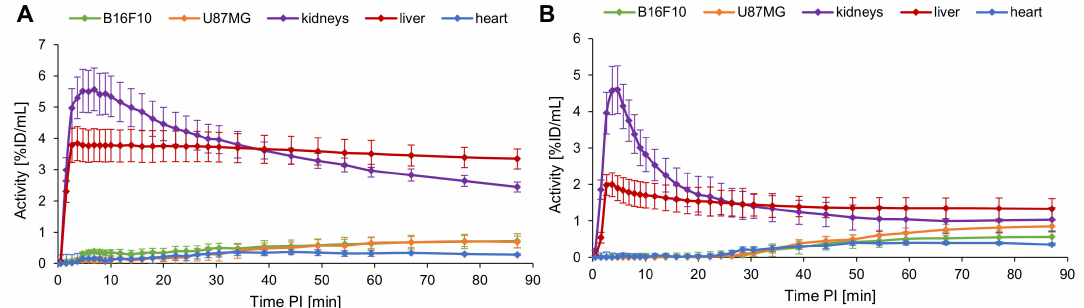
Figure 8. Depiction of the TACs for B16F10 and U87MG tumors, kidneys, liver and heart over 90 min PI for [ 18 F] 2 ( A ) and [ 18 F] 4 ( B ) ( n = 3). Values are depicted as mean; error bars represent